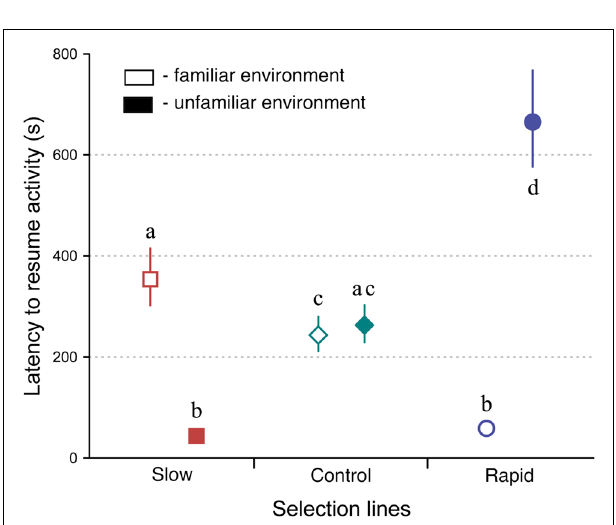
FIGURE 3 | Latency to resume activity (back-transformed means ± 95% CIs) of selected slow (squares), rapid (circles), and control (diamonds) developing crickets in familiar (open symbols) and unfamiliar environments (closed symbols). Different letters denote significant differences at P < 0.05.